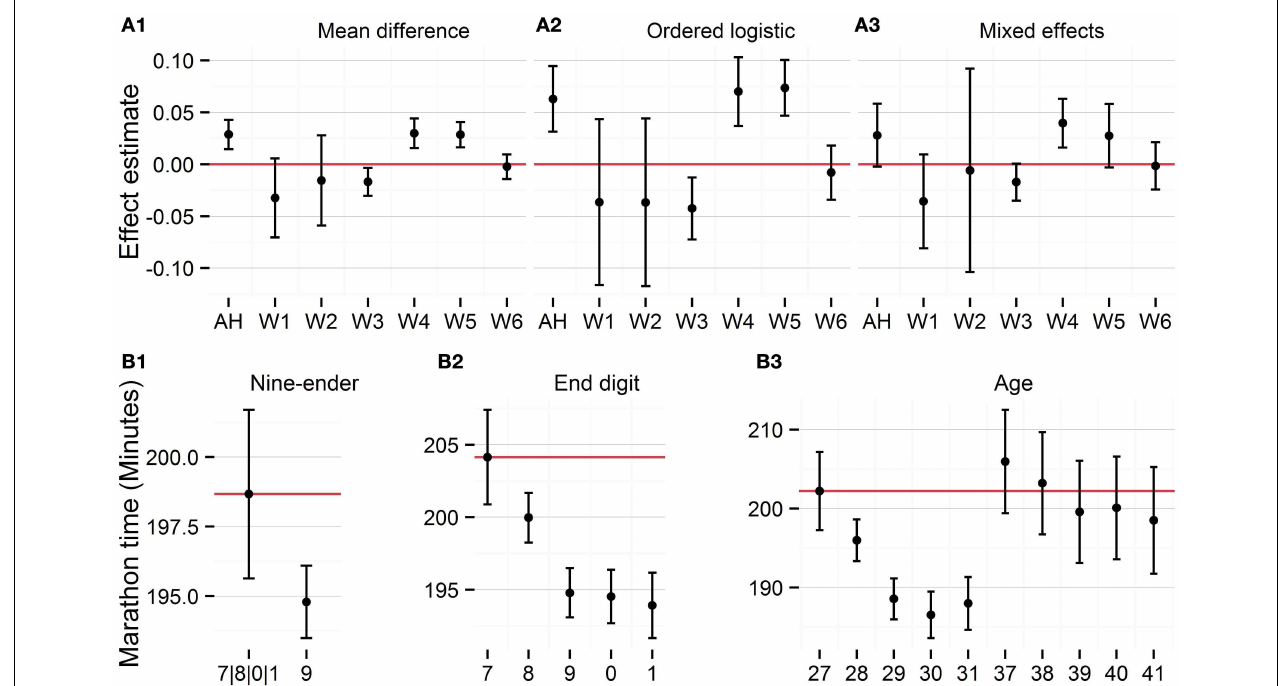
FIGURE 1 | Validation of nine-ender effect in Study 1 (A1–A3) and Study 5